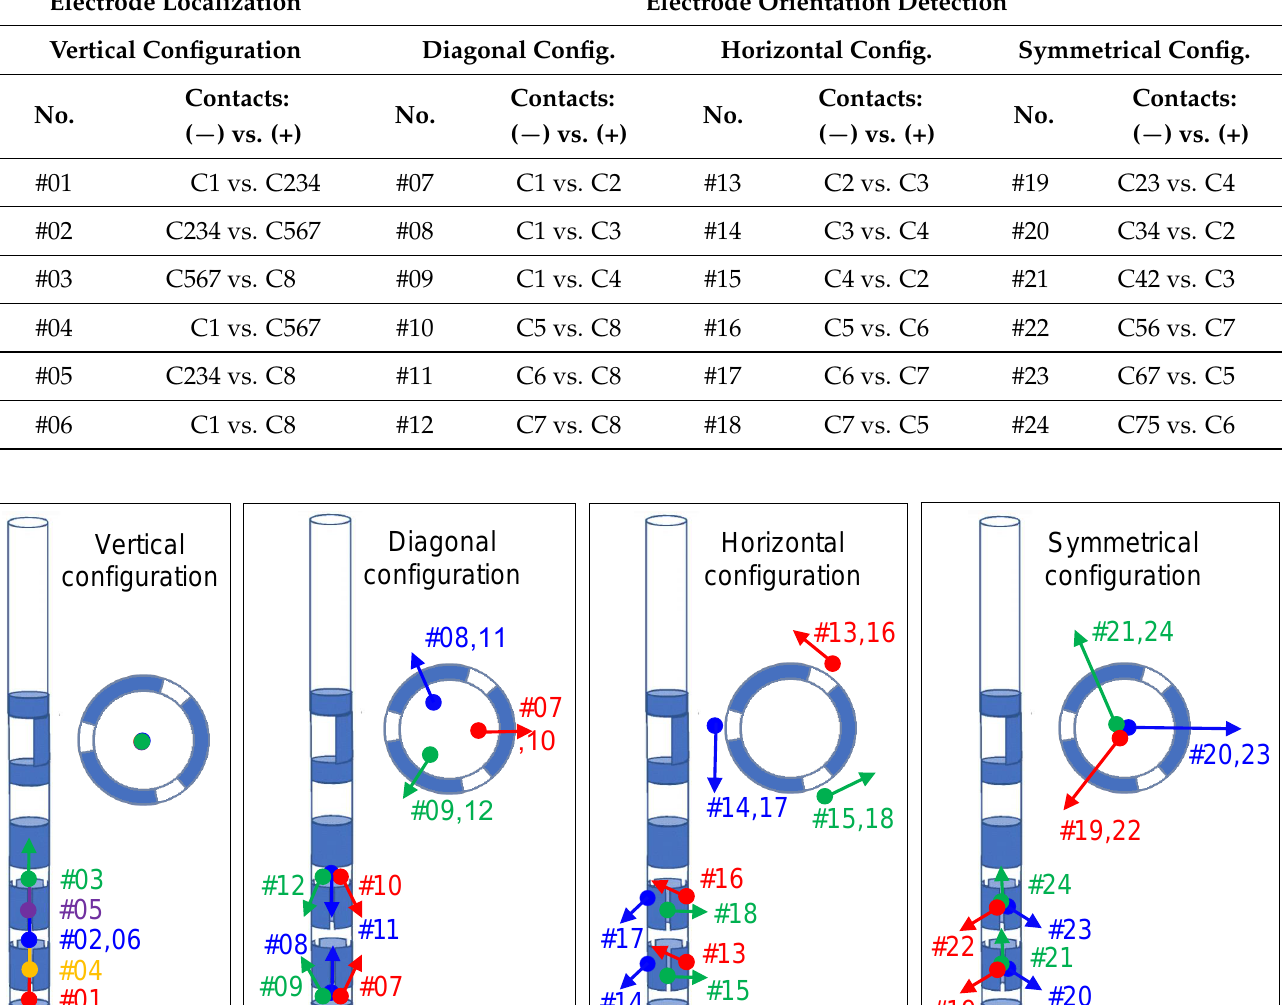
Table 1. Performed MEG measurements.